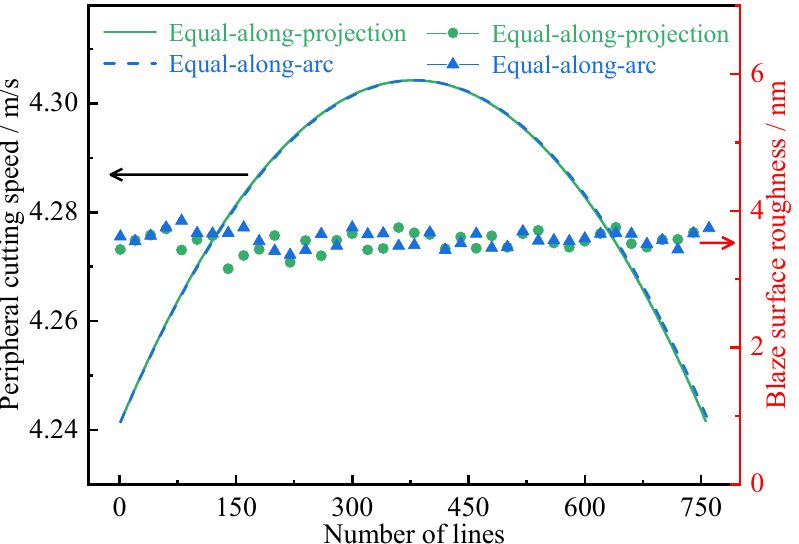
Figure 10. Peripheral cutting speed and surface roughness distribution in the diameter direction.